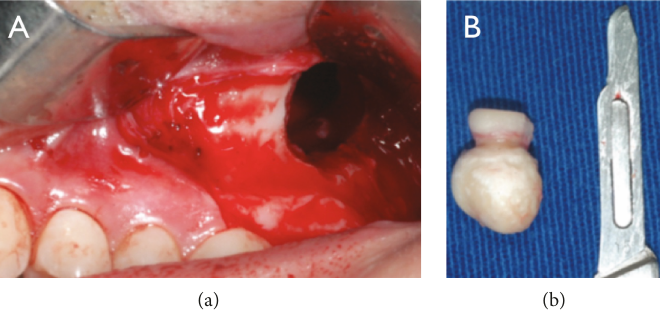
Figure 2: Transoperative images. (a) Caldwell-Luc access. (b) Third molar with calci fi ed mass associated with the roots.